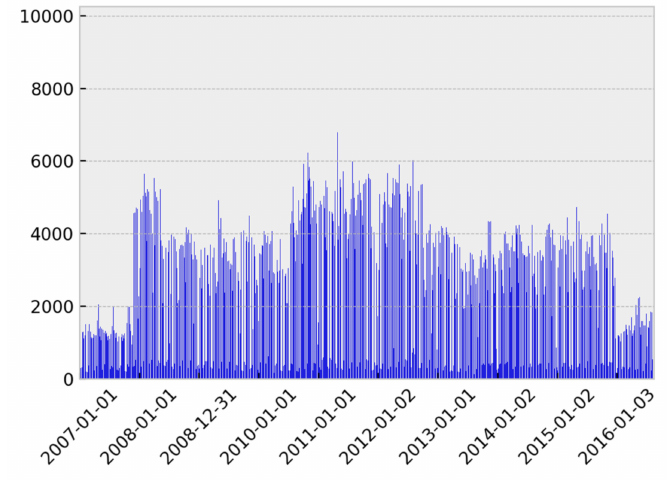
Figure 4. Amount of Reuters news by publication date.